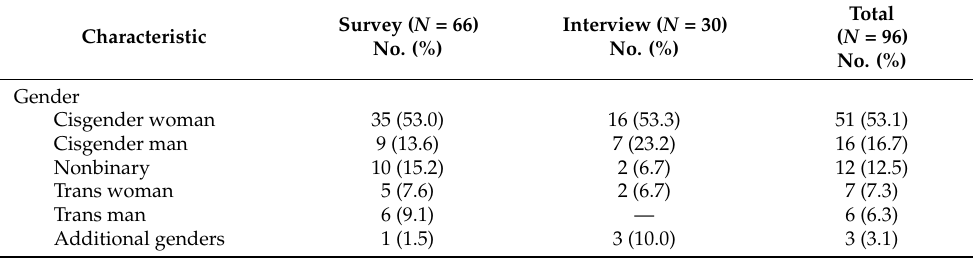
Table 1. Participants’ demographic characteristics ( N =